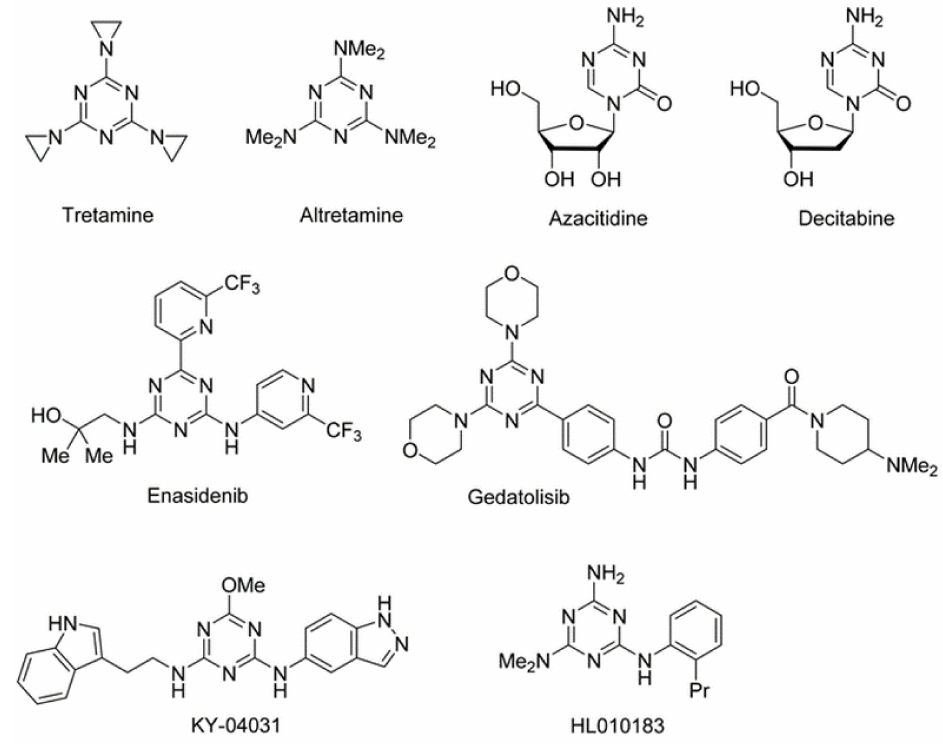
Figure 1. 1,3,5-triazine-based anticancer